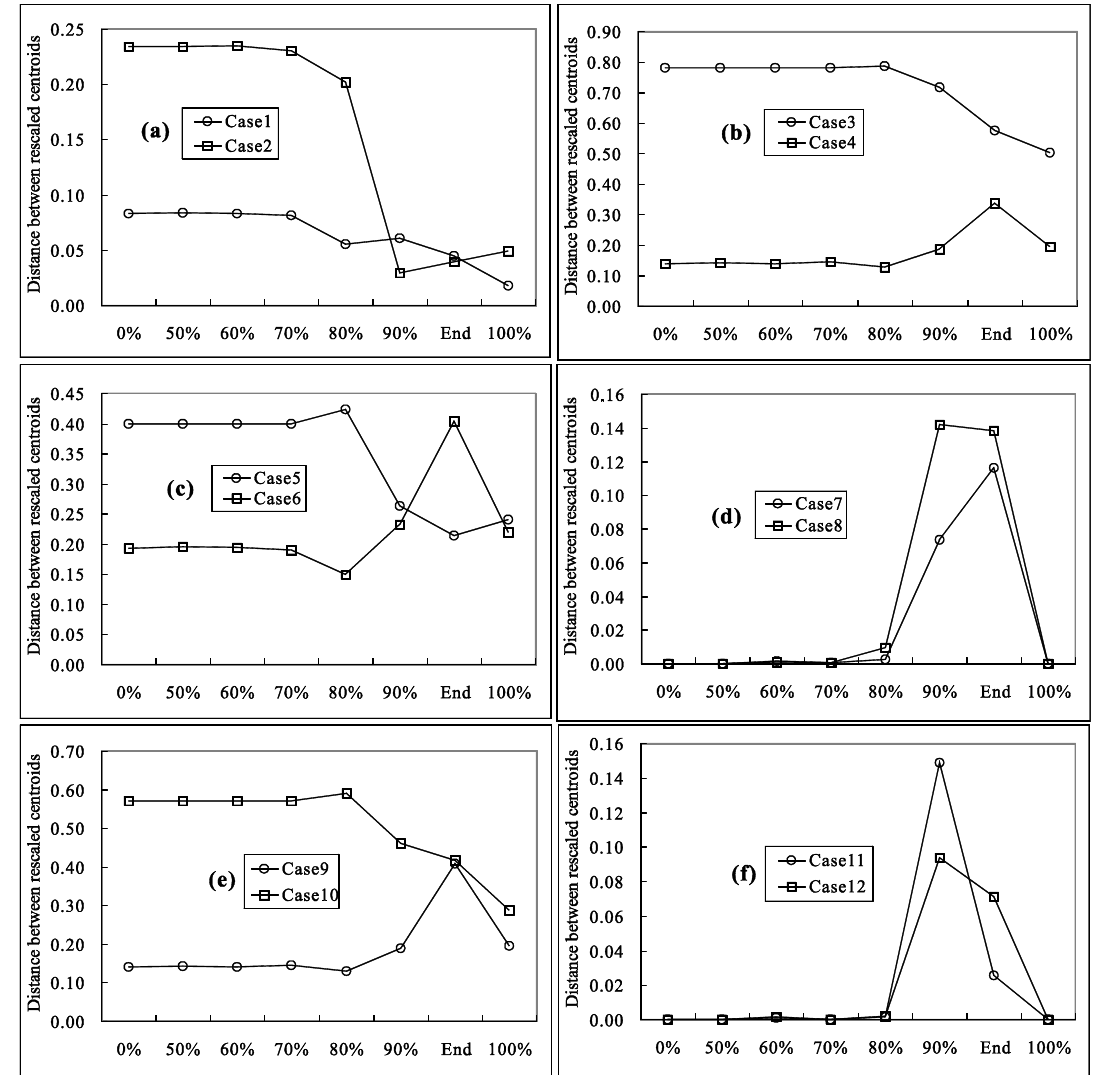
Figure 4. Distances of the rescaled centroids between the base case and the other cases at different stages of head recovery in the homogeneous cases.